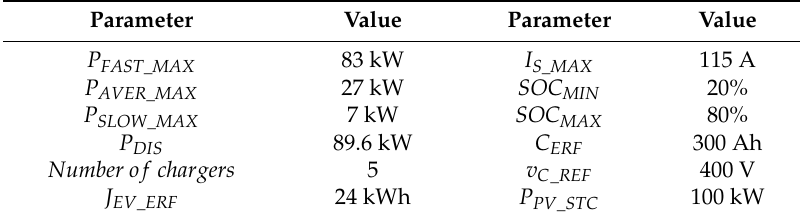
Table 1. Simulation parameters of the system.